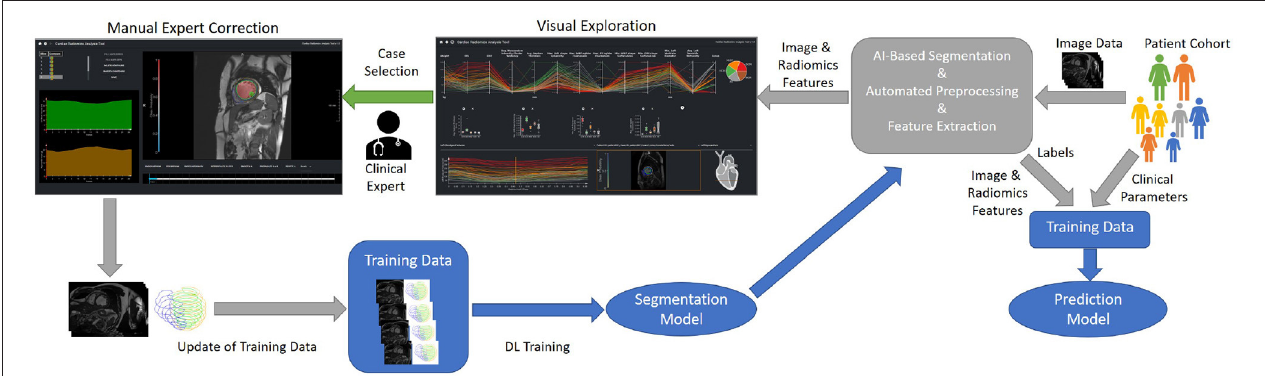
FIGURE 1 | Concept of an iterative process for the training and evaluation of the ML-based segmentation and classification models. On import, image data is automatically segmented, pre-processed, and features are extracted. The results of the automatic segmentation and classification is displayed in the visual exploration interface. In addition clinical experts can manually correct the segmentation results of detected outliers. These corrections can be used to refine the segmentation model.